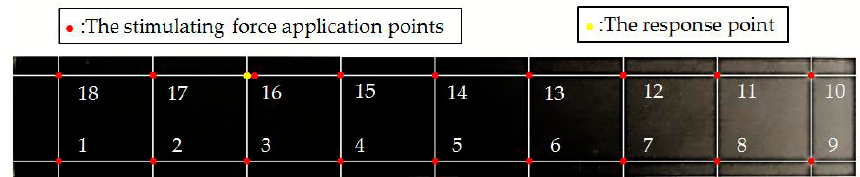
Figure Figure 3. The measuring points arrangement for the carbon fiber reinforced plastic (CFRP) laminated plate.